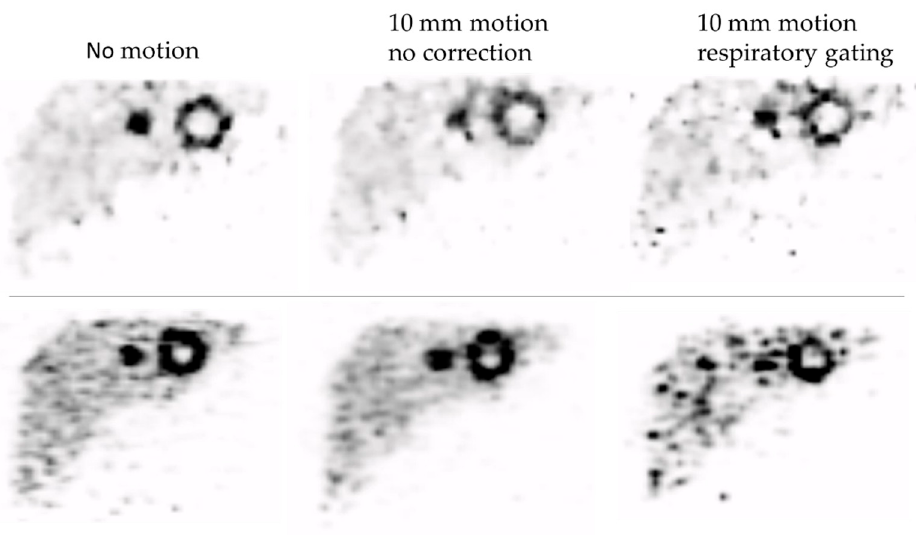
Figure 2. PET images (coronal slices) from the phantom with and without motion applied. The upper row of images is from the Discovery 710. The lower row is from the Biograph mCT. The grey scale maximum equals the true activity concentration in the hot spheres, with minimum at zero.